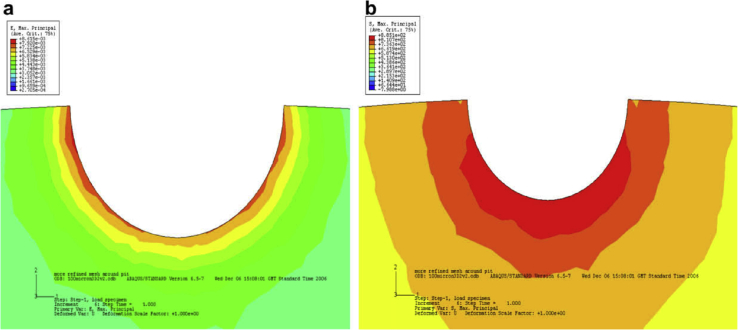
FE model showing distribution of (a) maximum principle strain; (b) maximum principle stress for a 100 μm diameter pit in plan view. Red regions denote areas of high strain and stress respectively. Green regions denote areas of low strain and stress respectively. From Turnbull et al. [2009].23